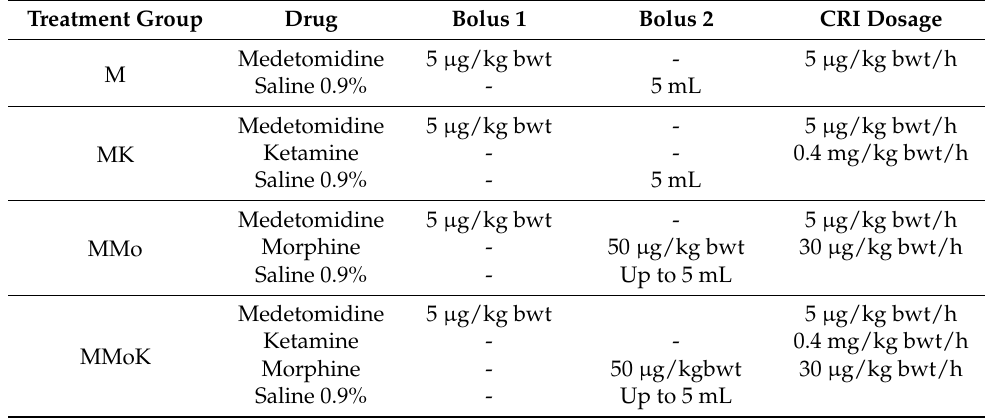
Table 1. Bolus and CRI dosages of the four sedation protocols. M (medetomidine), K (ketamine), Mo (morphine), ml (milliliter), mg (milligram), µ g (microgram), h (hour). Treatment Group Drug Bolus